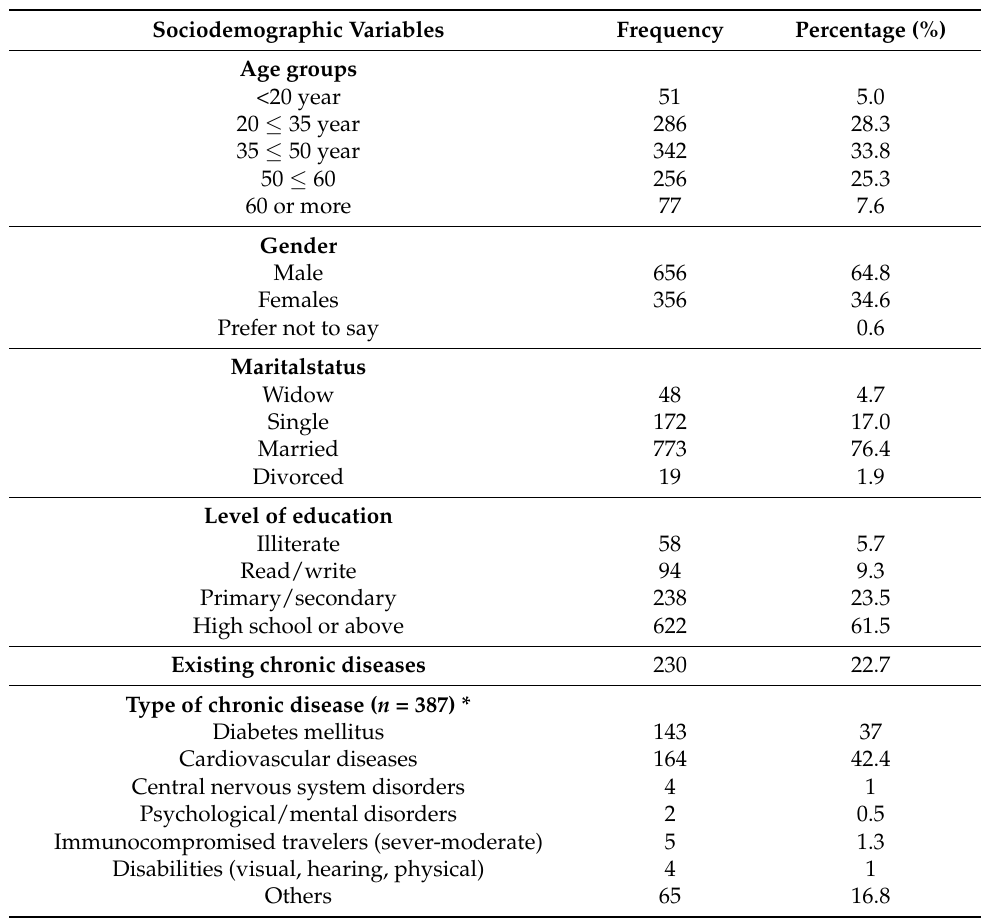
Table 1. Responses to items on sociodemographic, level of education, and chronic diseases of participating pilgrims ( n =